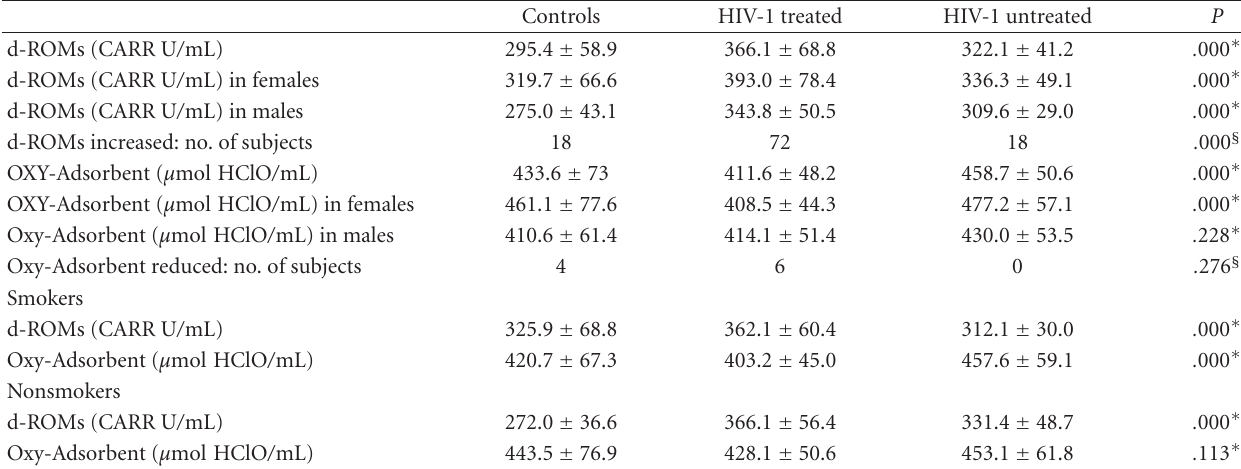
Table 2: Comparison of d-ROMs and Oxy-Adsorbent tests between the three